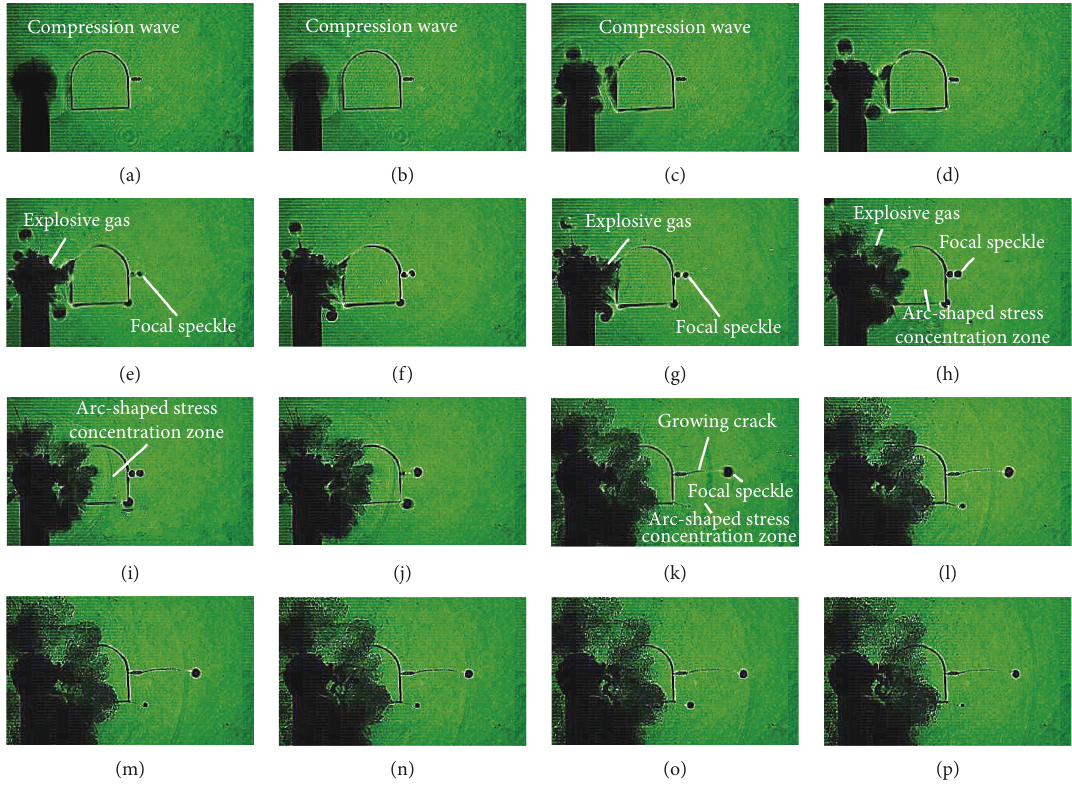
Figure 4: Aseriesofcausticspicturesoftheexplosionloadsactingontheoriginalcrackoftheadjacenttunnels.(a) t � 30 μ s,(b) t � 40 μ s,(c) t � 50 μ s, (d) t � 60 μ s, (e) t � 70 μ s, (f) t � 80 μ s, (g) t � 90 μ s, (h) t � 130 μ s, (i) t � 150 μ s, (j) t � 170 μ s, (k) t � 250 μ s, (l) t � 270 μ s, (m) t � 290 μ s, (n) t � 310 μ s, (o) t � 330 μ s, and (p) t � 350 μ s.